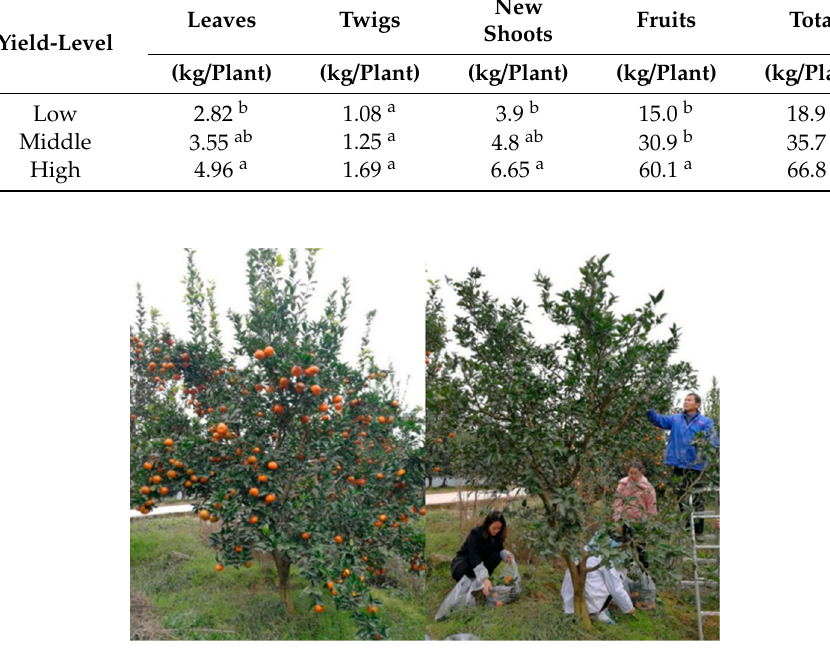
Table A1. The fresh weight (FW) in newly development parts of citrus trees with respect to yield level. The di ff erent letters (a,b) in the table represent significant di ff erences ( p < 0.05) among yield-levels.